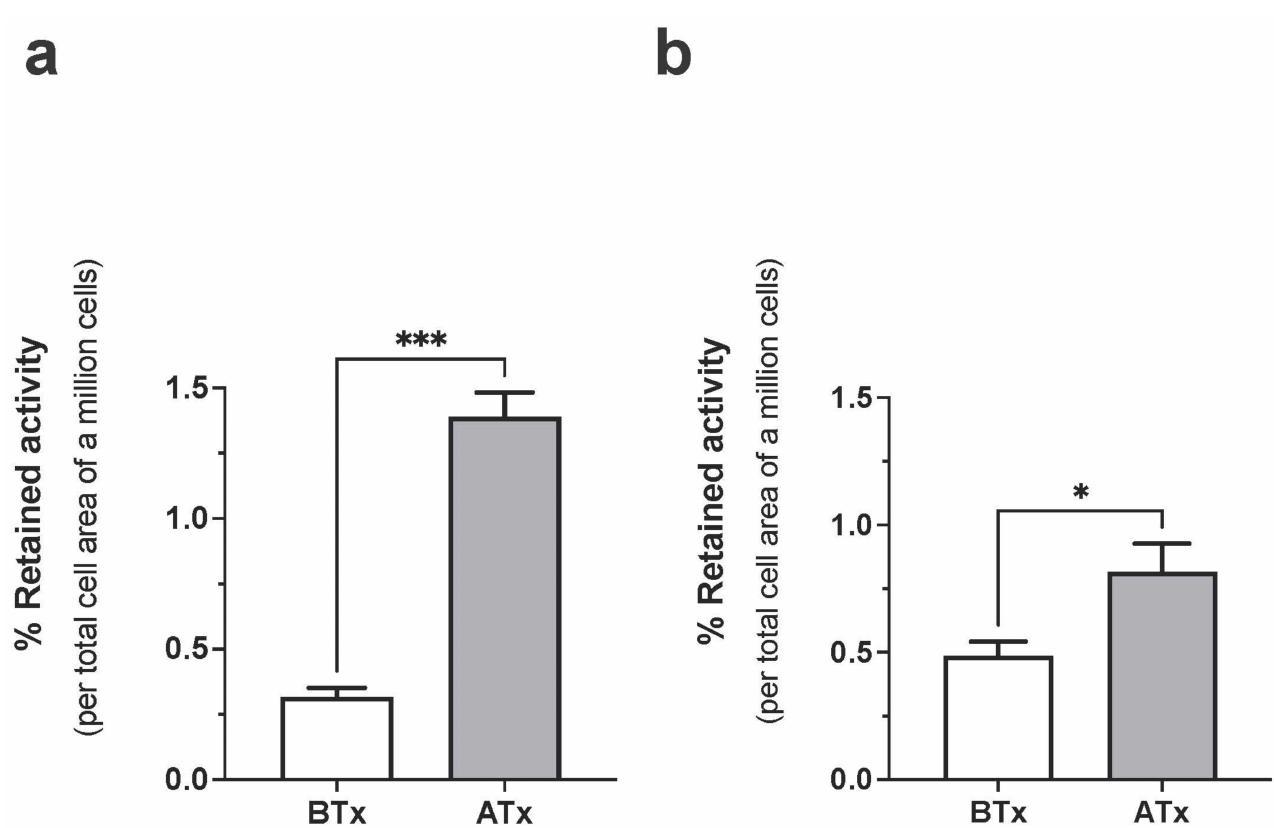
Figure 2. Binding of 68 Ga-C2Am to untreated (BTx) and drug-treated (ATx) MDA-MB-231 ( a ) and COLO205 ( b ) cells. Fraction of retained activity (%), normalized to total membrane surface area is shown for both cell lines. Two-tailed, pairwise t -test, unequal variance. * p < 0.05, *** p < 0.0005, Re- tained activity (%) (mean ± SEM, N = 3 per group). BTx, Atx, before and after treatment,